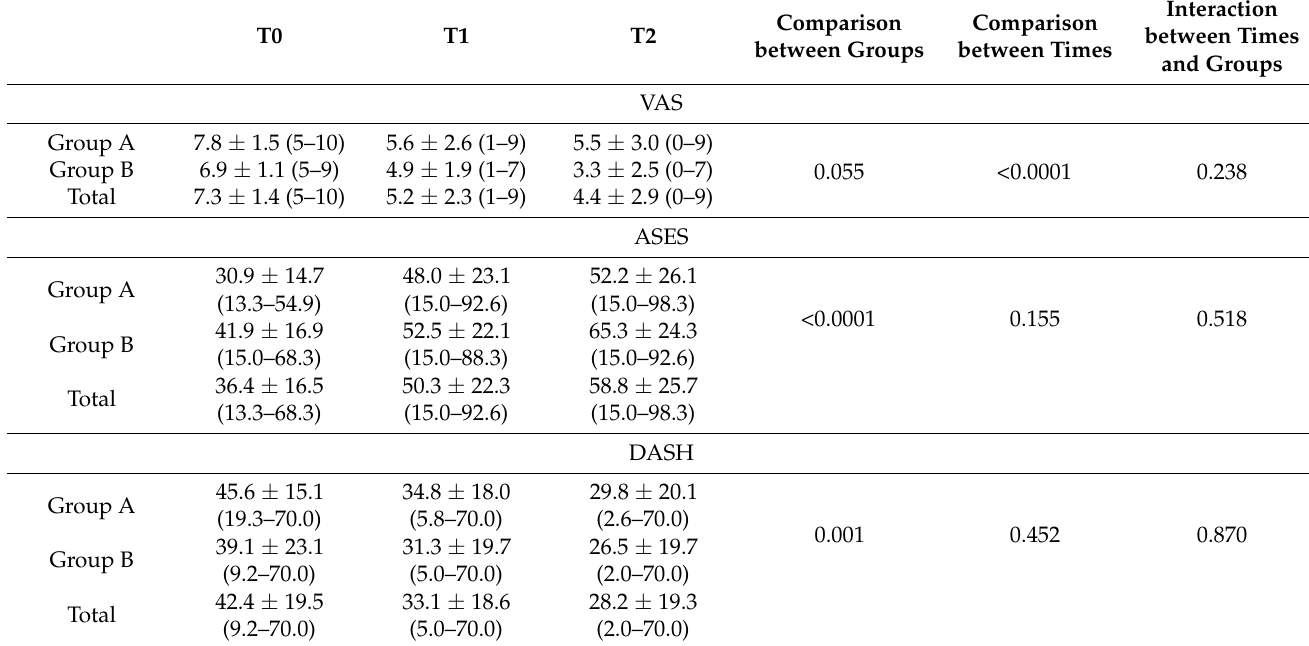
Table 2. Mean ± SD and range of the VAS, ASES, and DSH variables by treatment and detection time, and repeated-measures ANOVA